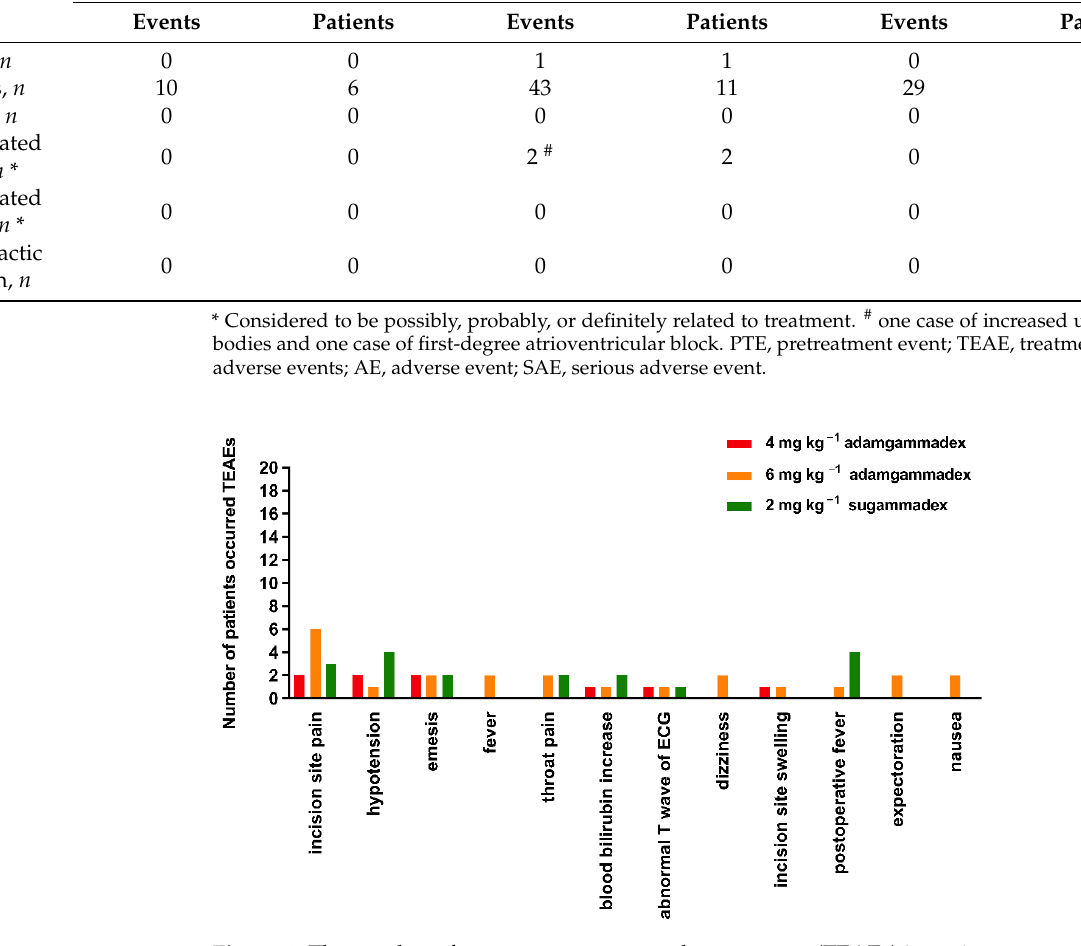
Figure 4. The number of treatment ‐ emergent adverse events (TEAEs) in patients.